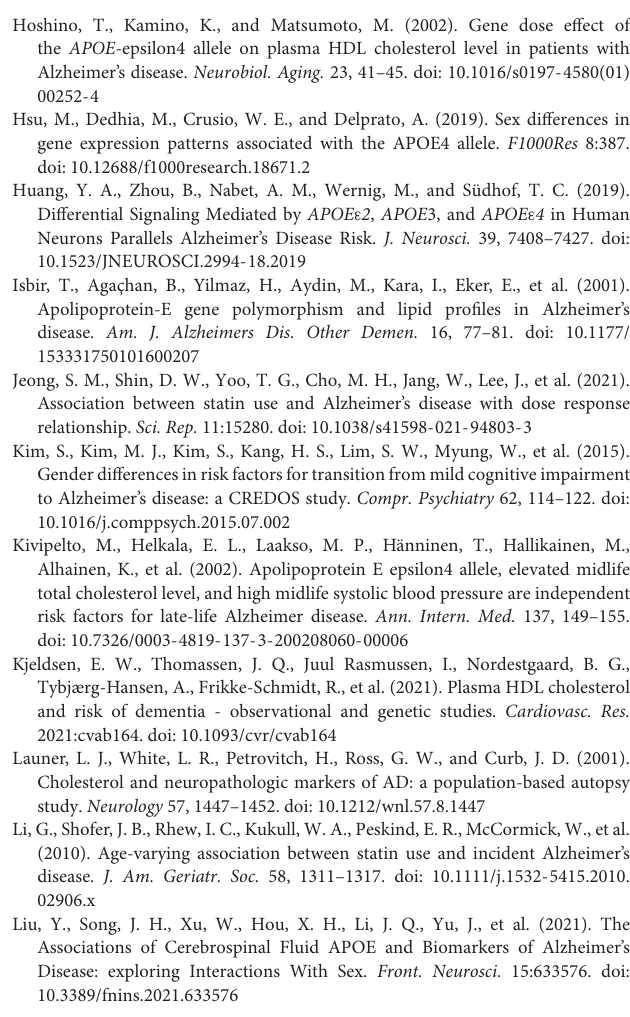
Supplementary Table 1 | Comparison of lipids between AD and HCs groups (Adjusting for age); Values are expressed as mean (standard deviation); AD, Alzheimer’s disease; HCs, healthy controls; APOE ε 3 +, APOE ε 3 carriers; Male and APOE ε 3 +, male APOE ε 3 carriers; Male and APOE ε 3 − , male APOE ε 3 Supplementary Table 2 | Comparison of lipids between APOE ε 3 + group and APOE ε 3 − group (Adjusting for age); Values are expressed as mean (standard deviation); AD, Alzheimer’s disease; HCs, healthy